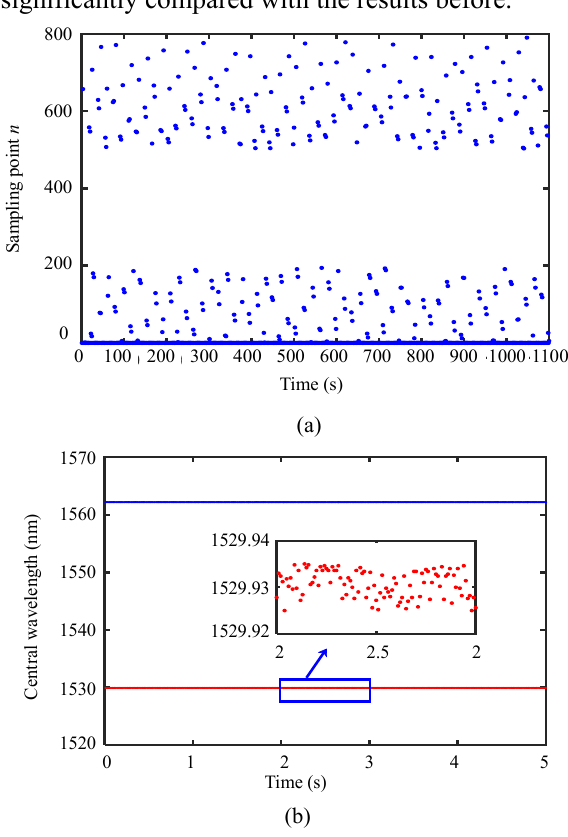
Fig. 10 FIR filter designed in this paper: (a) the h (m) calculated with m and (b) the amplitude-frequency curve of FIR